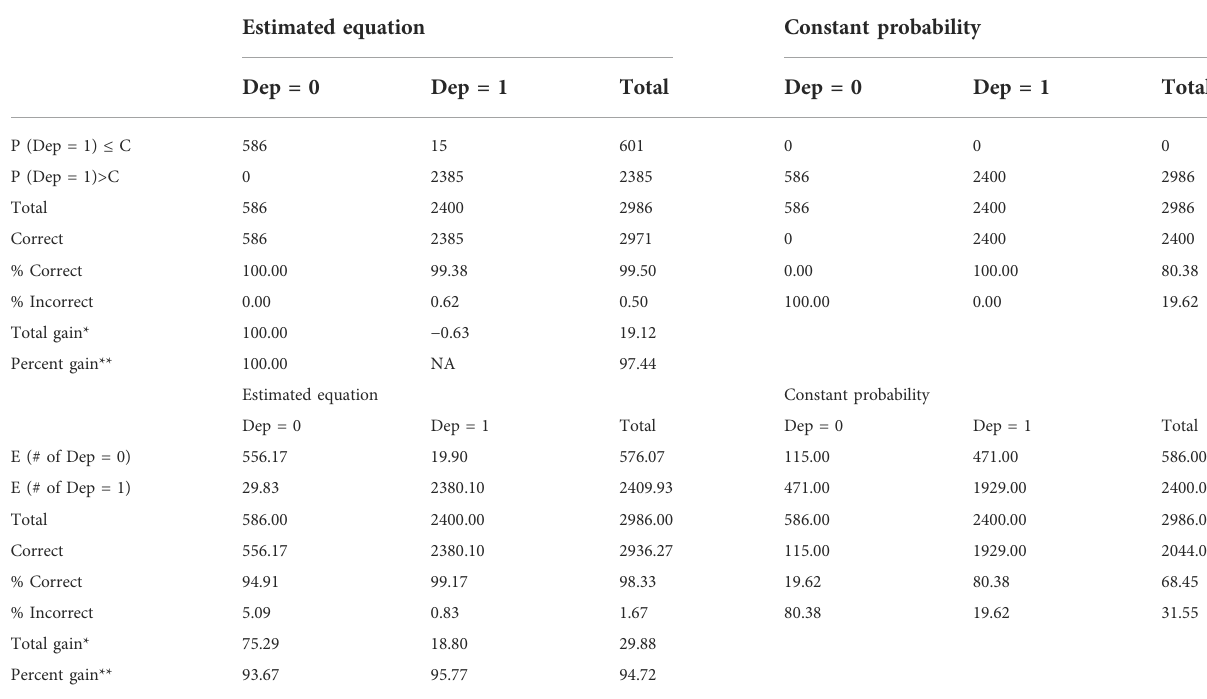
TABLE 5 Expectation-prediction evaluation for binary speci fi cation. Success cutoff: C = 0.5